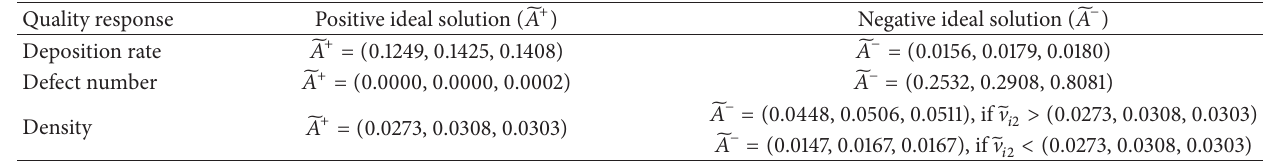
Table 4: Positive and negative ideal solutions for each quality response.